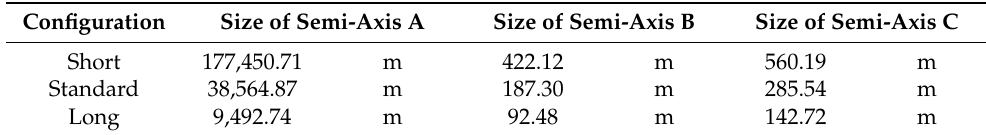
Table 2. Error ellipsoid semi-axes size for configurations short, standard, and long.